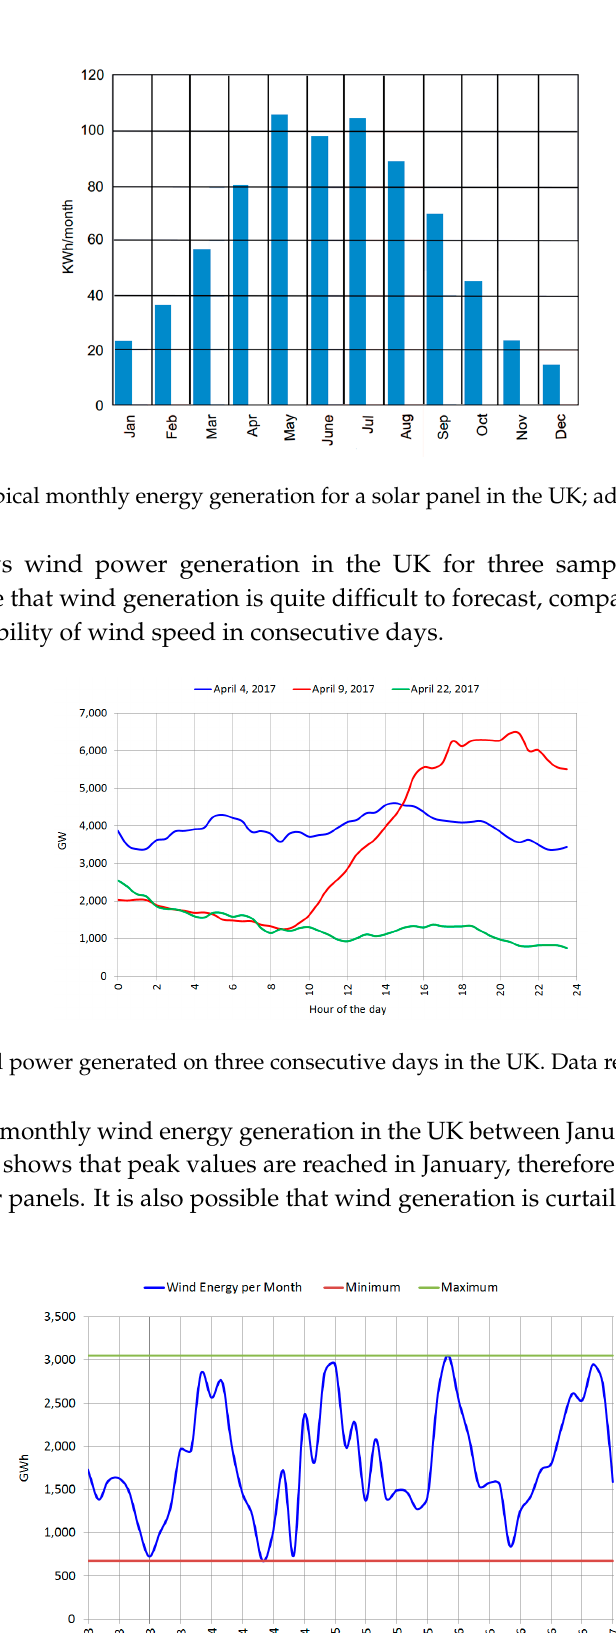
Figure 18. Wind energy generated monthly in the UK between January 2013 and April 2017. Data retrieved from [61].